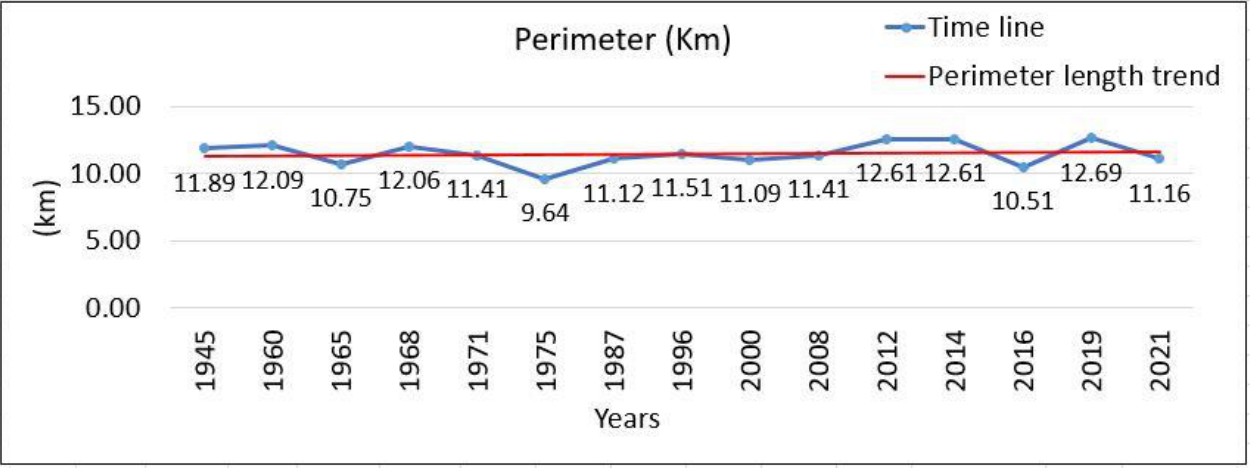
Figure 9. Lagoon’s perimeter fluctuations during the study period. The maximum diameter of the lagoon ranges from 3.25 km (min) to 4.54 km (max), while the mean rate is 3.56 km. The respective rates corresponding to the minimum diameter of the lagoon are 1.98, 2.24 and 2.03 km, respectively. Finally, the rates of the perpendicular distance to the open sea coastline (DPER) range from 1.65 km (min) to 1.77 km (max), while the mean rate is 1.71 km. The respective rates of the parallel distance to the open sea coastline (DPAR) range from 2.82 km (min) to 4.05 km (max), while the mean rate is 3.25 km.